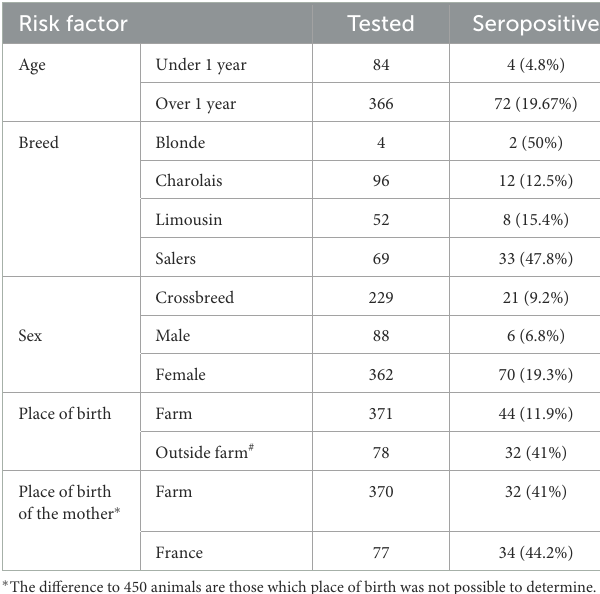
TABLE 1 Number of tested animals and seroprevalence by risk factor, namely age, breed, sex, place of birth, and place of birth of the